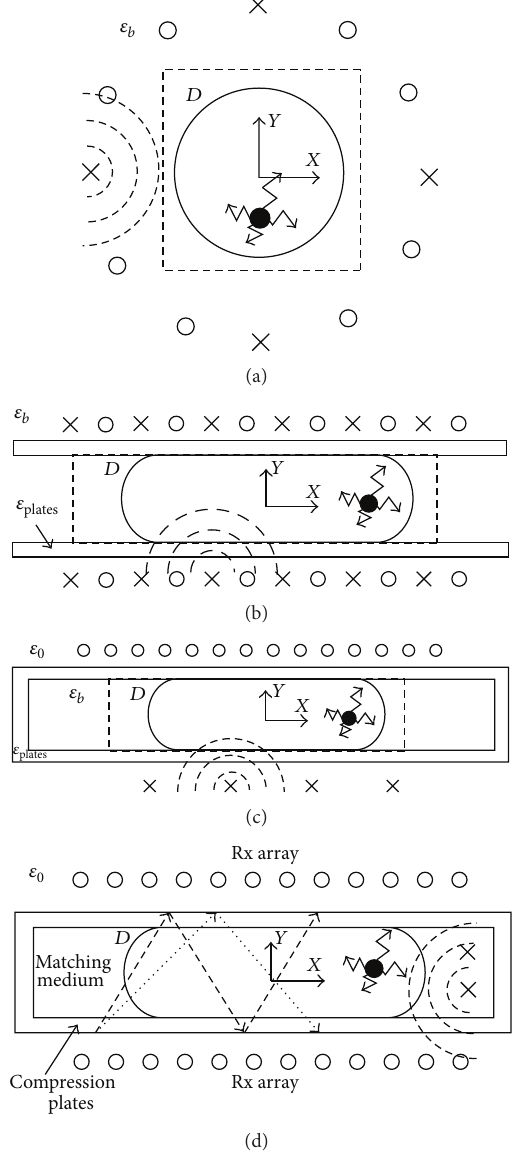
Figure 1: MT configurations analyzed in this paper. (a) Circular MT configuration. (b) Array configuration. (c) Camera configuration. (d) Waveguide configuration. Circles and crosses represent the positions of Rx and Tx antennas, respectively. 𝐷 represents the MT solution